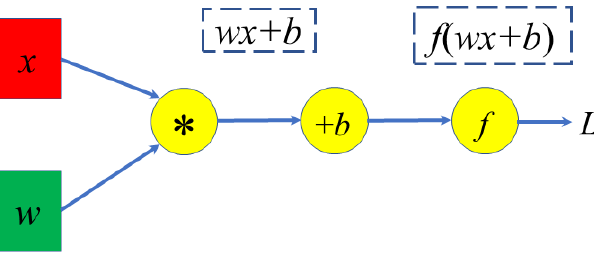
Figure 6. Schematic diagram of the BP neural network structure. Note: The weight w represents the connection strength; the bias b indicates whether or not the node is easy to activate (threshold).